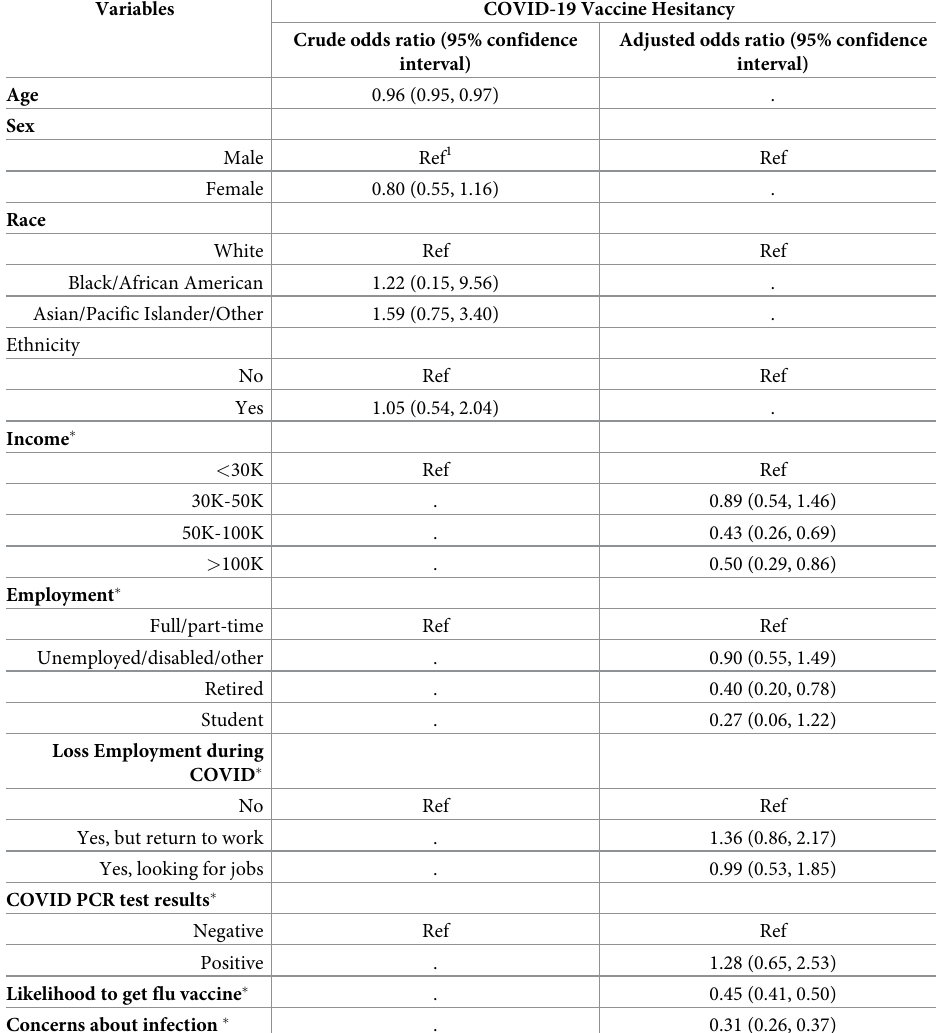
Table 4. Factors predicting COVID-19 vaccine